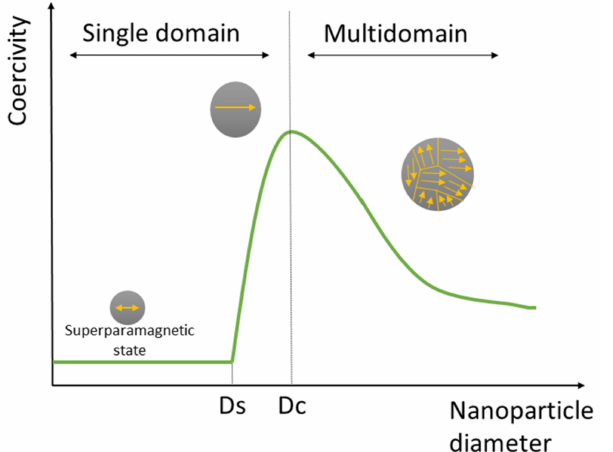
Figure 2. Dependence of coercivity on particle size: Ds and Dc are the thresholds of superparamag- neti с and critical size,